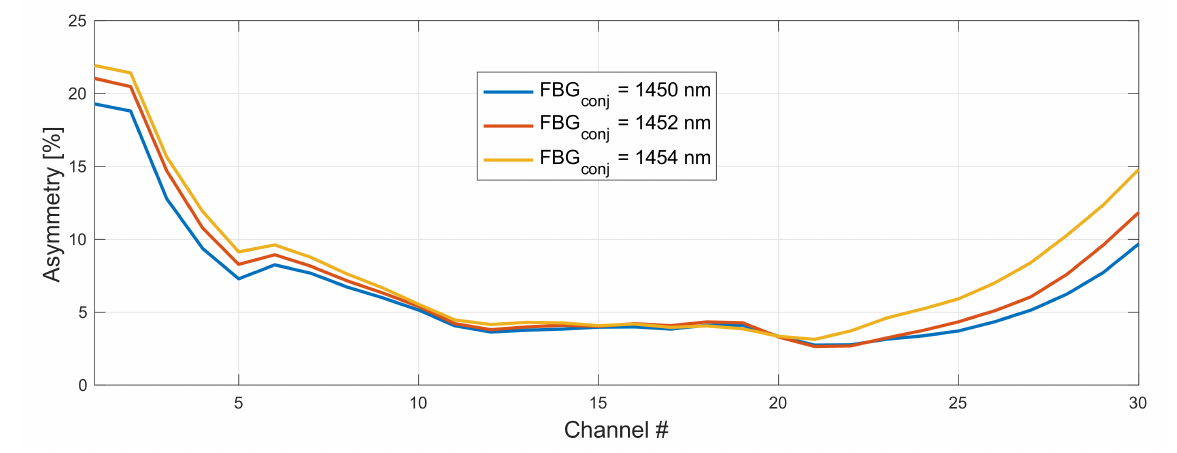
Figure 7. Impact of a FBG choice on asymmetry performance in 192–198 THz grid. FBG for original WDM grid was set to 1458 nm and conjugated varied from 1450–1454 nm.